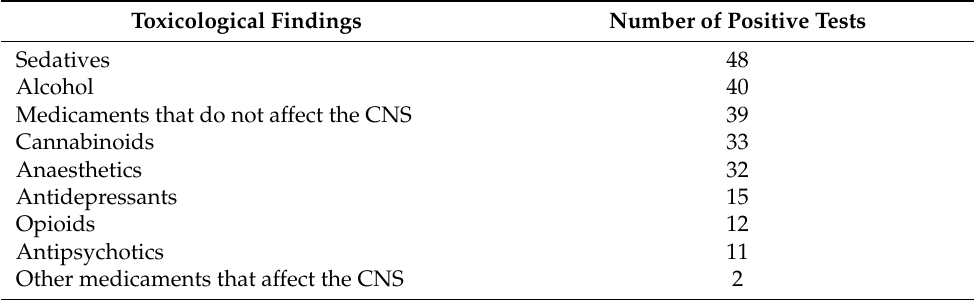
Table 6. Distribution of substances revealed by toxicological